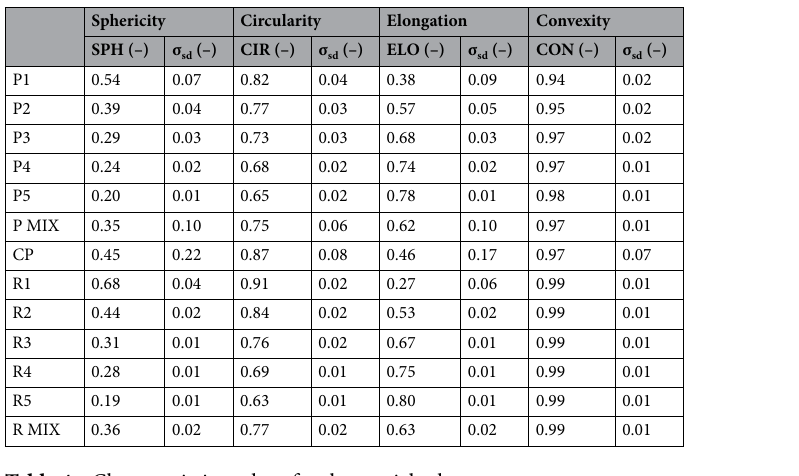
Table 4. Characteristics values for the particle